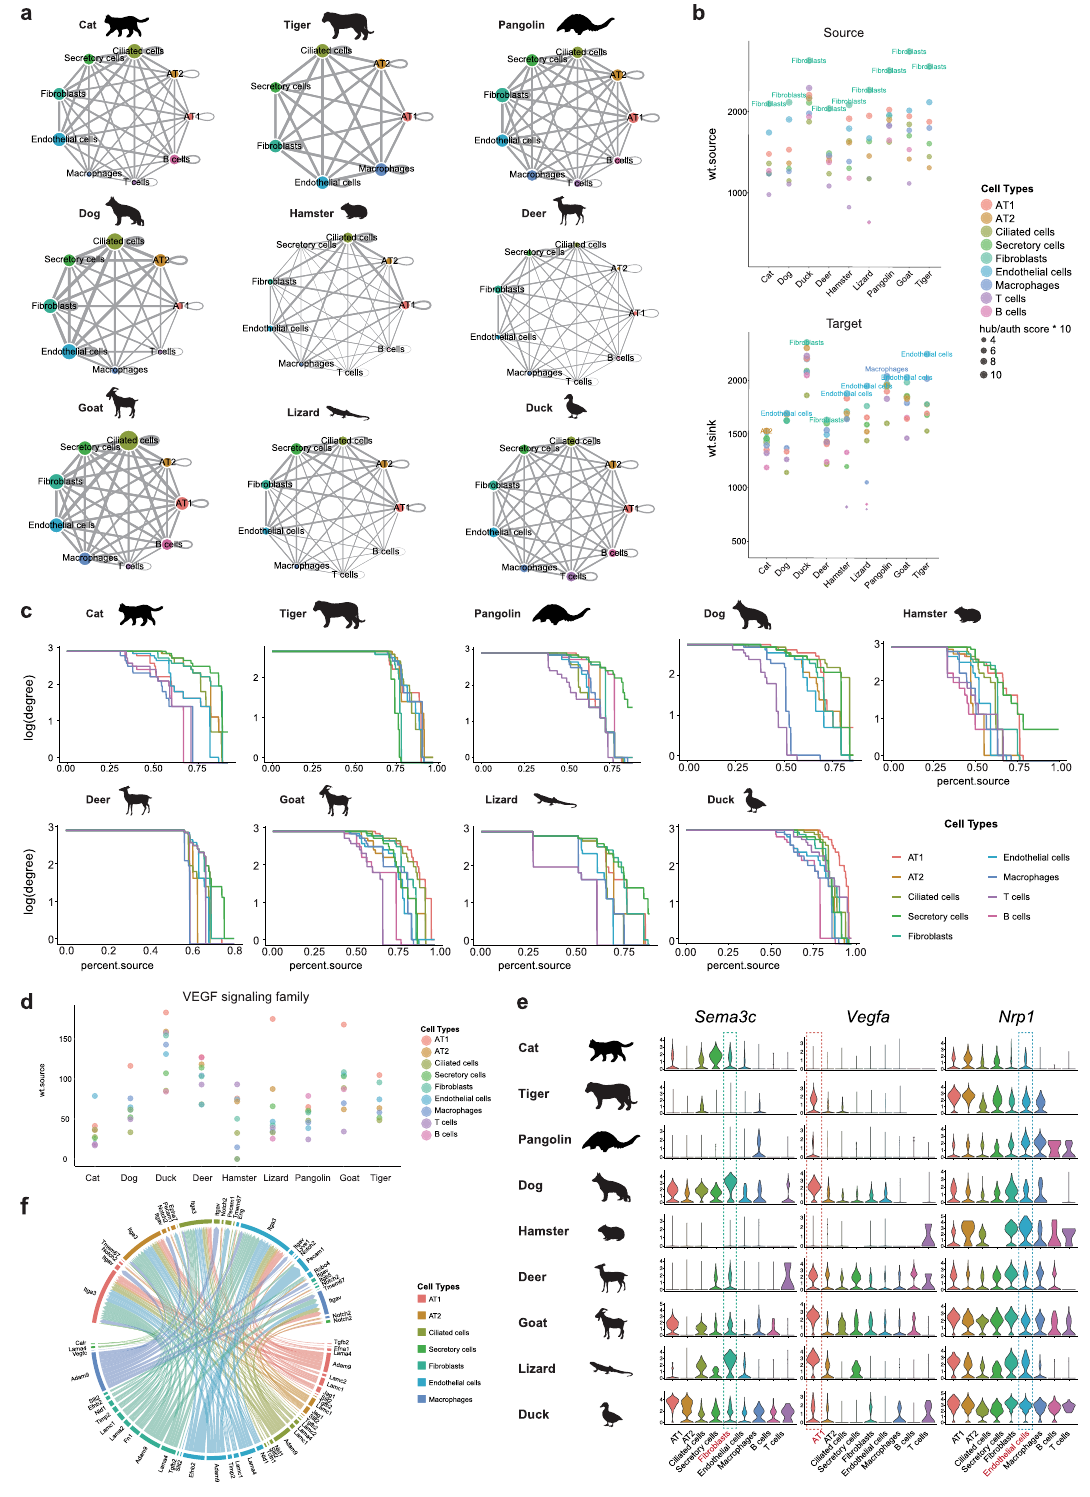
Fig. 5 Conserved pulmonary cellular connectomes. a Communication network of receptor – ligand pairs between lung cell types of indicated species. Cell type was represented by colored node, of which the size was directly proportional to sum of receptor – ligand pairs between this node and all other nodes. Edge width was directly proportional to number of receptor – ligand pairs between two connected nodes. b Plot (upper) showing source weight and hub score of various cell types in indicated nine species. Plot (lower) showing target weight and authority score of nine cell types. c Comparison of degree rankings and the effect of thresholding of lung cell types in indicated species. The x -axis ( “ percent.source ” ) is percent of cell type expressing the marker, and the y -axis is the degree of each node plotted on a logarithmic scale. d Plot showing source weight of VEGF signaling family in nine cell types. e Violin plots showing expression level of indicated ligand and receptor genes within each cell type of lung in different species. f Circos plot of mammalian-speci fi c conserved connectome in cat. Receptors and ligands were displayed near the upper and lower half circle,